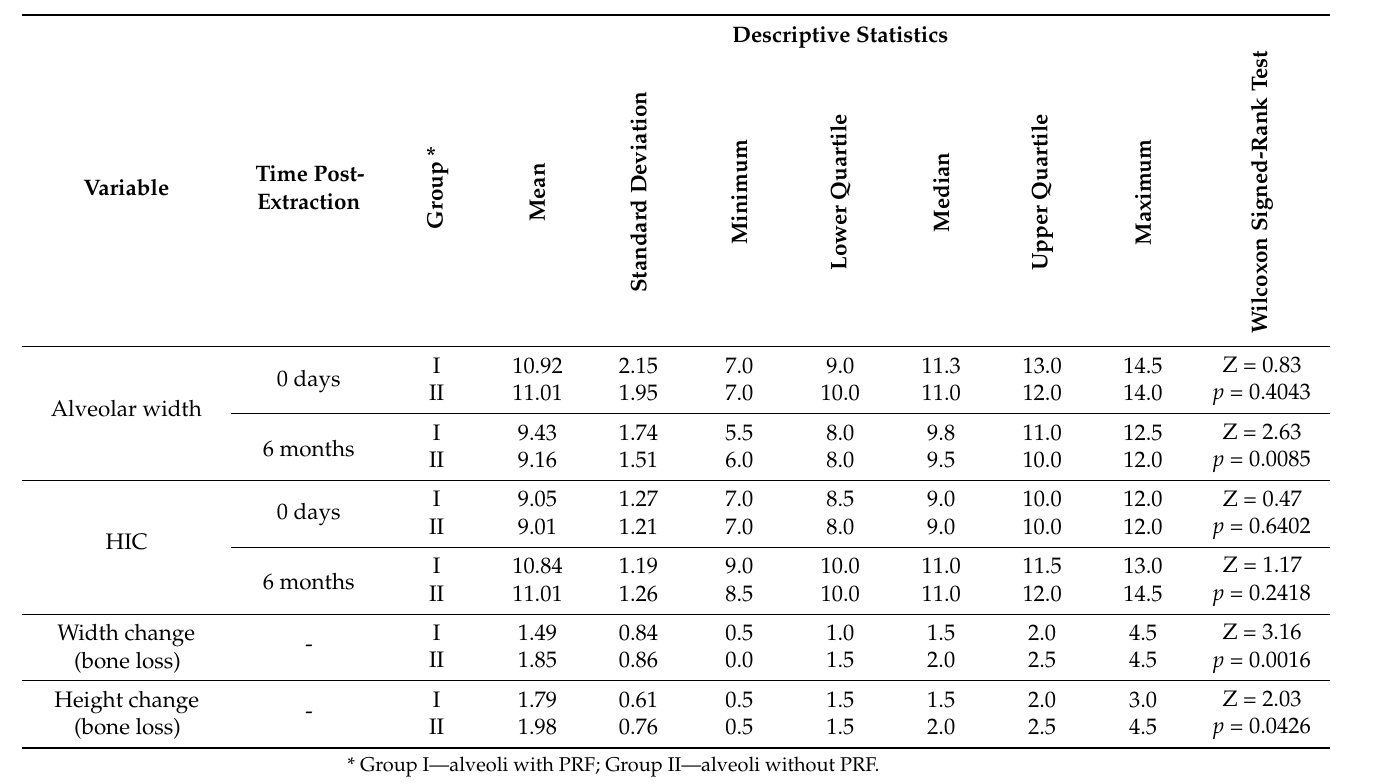
Table 3. The mean values of alveolar width and height in Group I (PRF) and Group II (no PRF) measured 10 days and 6 months post-extraction and the change of values in